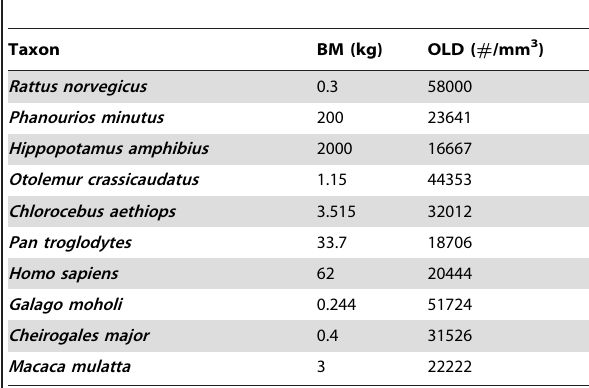
Table 2. Mammal body masses and osteocyte lacunar densities from Bromage et al. [12].